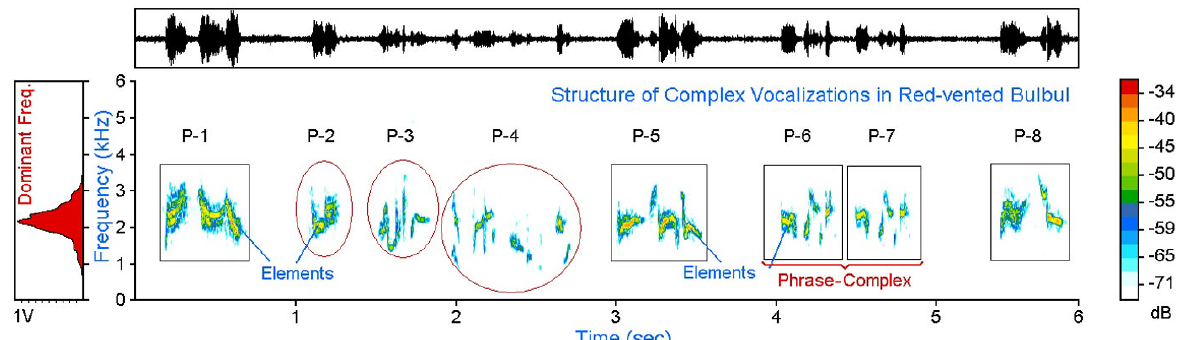
Figure 2. Spectrograms of complex vocalizations produced by Red-vented Bulbul during Mate Acquisition Display.